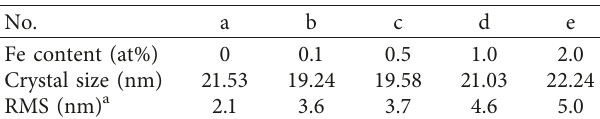
Figure 2: Raman spectra of (a) bare TiO (d) 1.0 at%, and (e) 2.0 at% of Fe-doped TiO 2 . Table 1: Crystallite size and roughness of TiO atomic ratios of Fe to Ti.